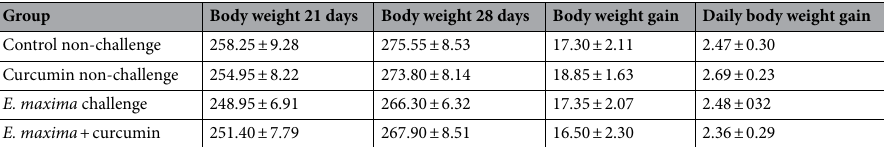
Table 1. Evaluation of body weight and body weight gain (in grams) of specific pathogen-free Leghorn chickens with or without Eimeria maxima challenge (7 days post-challenge). Data expressed as mean ± standard error. P >